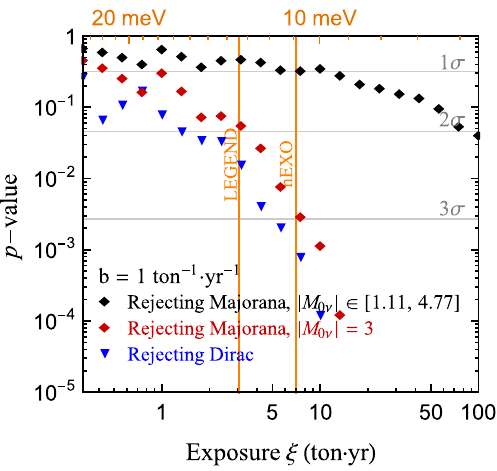
Fig. 2 Probability distributions of the test statistic − 2ln ( L obtained from the Monte-Carlo simulations by assuming neutrinos are Dirac (blue histograms) or Majorana (orange histograms) fermions. The experimental configuration is fixed as ξ = 5 ton · year and b = 1 ton − 1 · year − 1 . In the left panel, the NME is assumed to be completely known and fixed as NME takes a flat likelihood in the range of the fit. In each panel, the upper half one is obtained if a null signal has been observed (i.e., N exp tot = B ) in a future 0 νββ decay experiment,